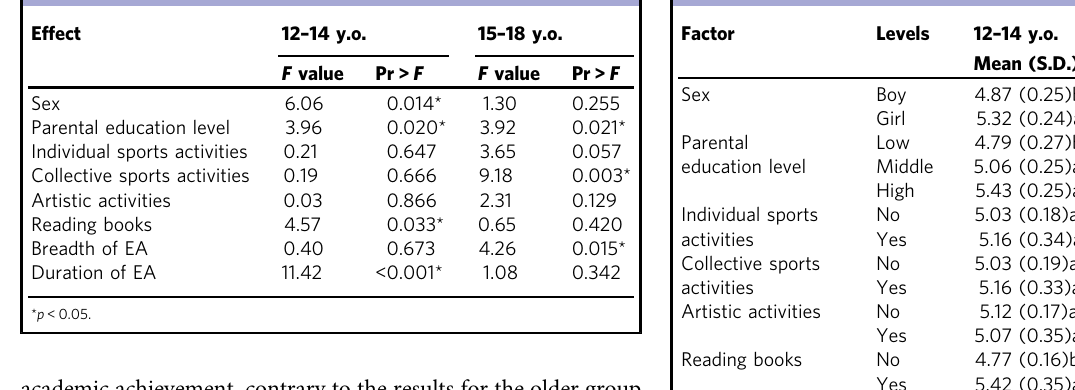
Table 2 Anova of the multilevel model for extracurricular activities (EA) and academic achievement as the dependent variable.